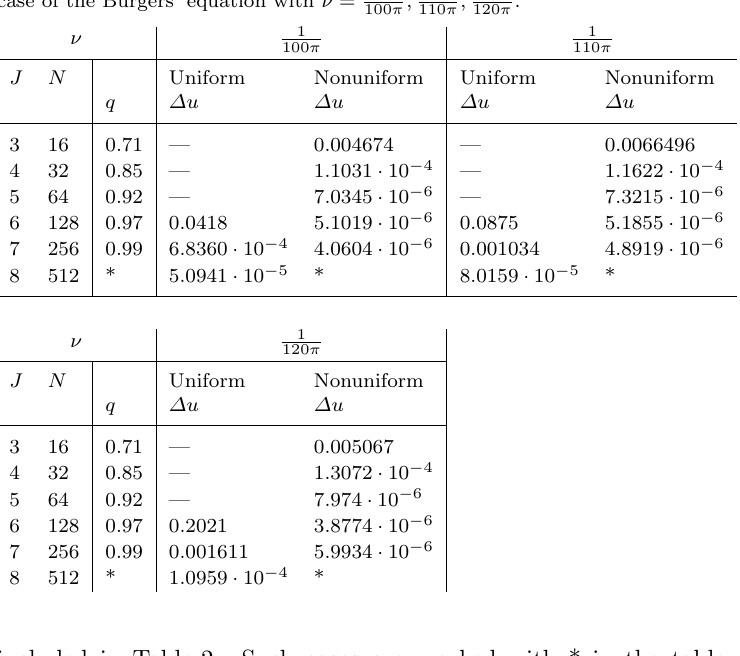
Maximal deviation from the exact solution ∆u against the resolution J in the case of the Burgers’ equation with ν = 1 ν 1